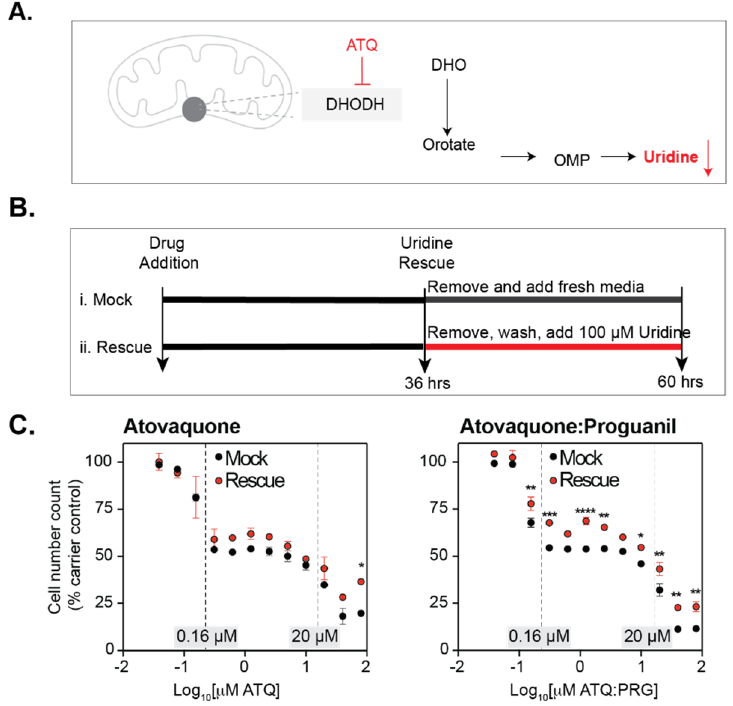
Figure 3. Effect of atovaquone and atovaquone-proguanil on cell proliferation. ( A ) Diagram of atovaquone mode of action. ( B ) Schematic of the experimental setup. Briefly, Vero E6 cells were grown in the presence of each drug or carrier for 36 h. Next, cells were treated as follows: (i) mock treatment, media with drug was removed, the monolayer was washed once with PBS and fresh media added; (ii) rescue treatment, media with drug was removed, the monolayer was washed once with PBS, and then media with 100 μ M uridine was added. For both conditions, cells were incubated for 24 h. ( C ) Effect of atovaquone and malarone on cellular proliferation. Each panel indicates the total cell count expressed as % of carrier control at different drug concentrations. Dashed lines indicate a range of concentrations from 0.16 to 20 μ M where the dose response effect was stable. p values were calculated using a two-Way ANOVA with Bonferroni correction. (* p < 0.05, ** p < 0.01, *** p < 0.001, **** p < 0.0001).